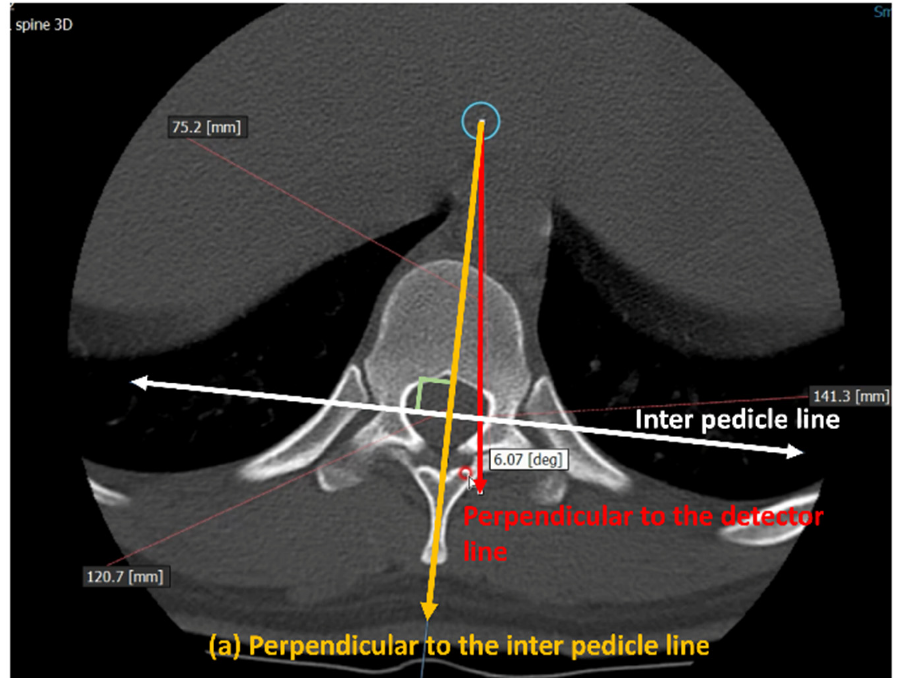
Figure 2. Measurements of reference spine axis angle (the basis for the spine) and spine variables. The most crucial line (a) is established by setting the center of the pedicle by checking the upper and lower tomography images of the spine trans-axial image and tracking it from the starting point of the pedicle. The image measures the degree of rotation of the spine concerning the pedicle on the horizontal plane of the CT. It shows a 6.07° clockwise rotation.